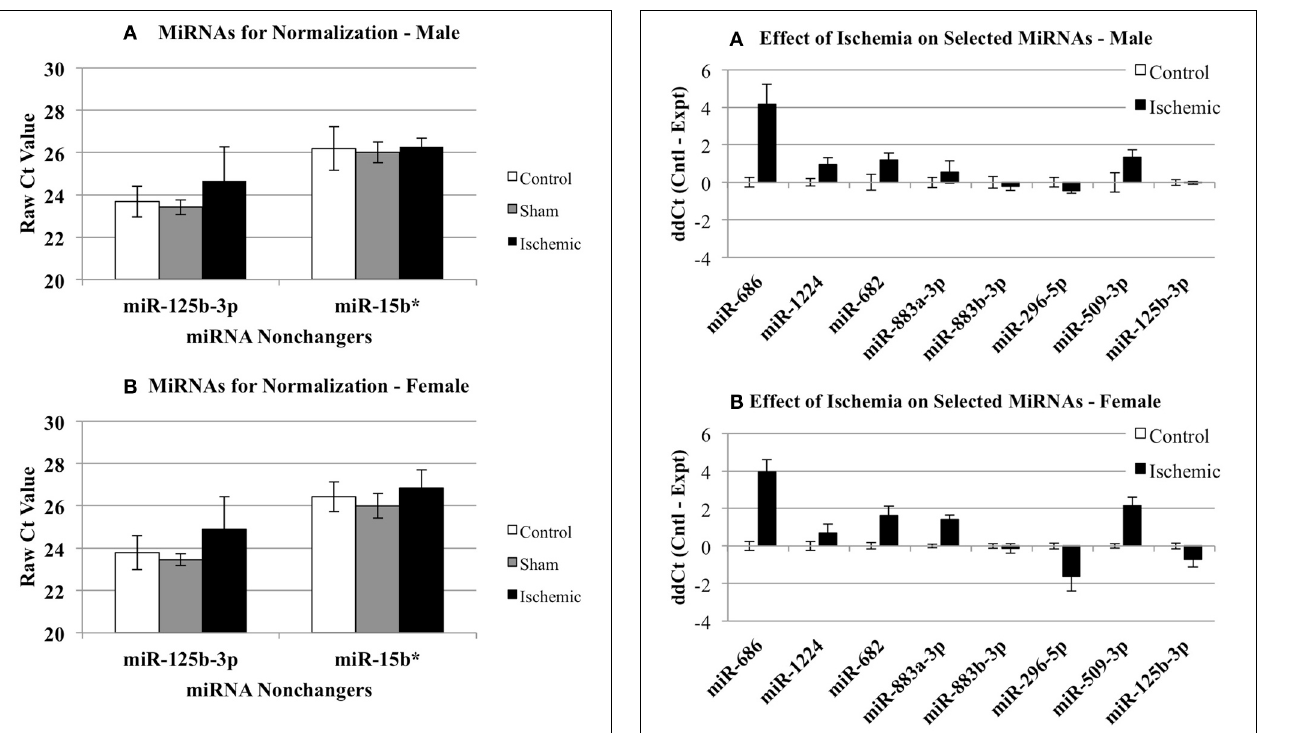
FIGURE 4 | Individual microRNAs regulated by ischemia in male and female mouse cortex. The graphs illustrate the (cid:2)(cid:2) Ct changes for specific miRNAs chosen for further validation by individual qRT-PCR. The graphs show expression of miRNAs in control (white bar) and ischemic (black bar) male (A) or female (B)